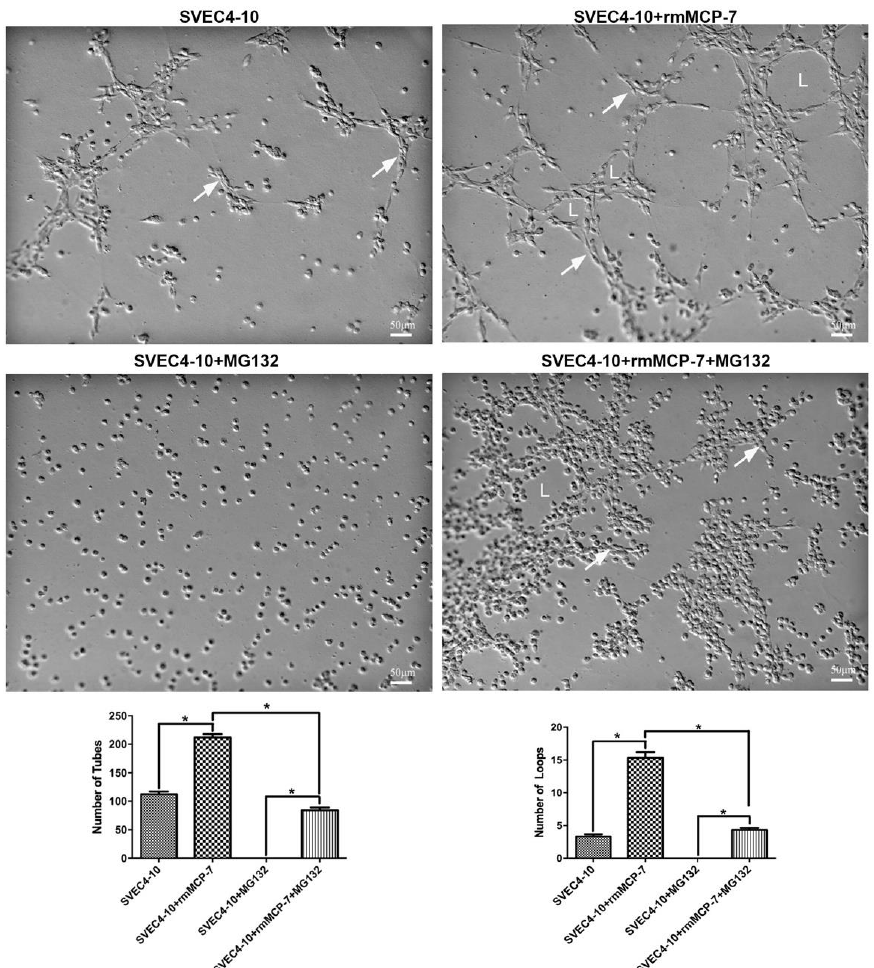
Figure 6. rmMCP-7 initiates tube formation even in the presence of the proteasome inhibitor MG132. When SVEC4-10 cells were cultured in the presence of MG132, in vitro angiogenesis was completely inhibited. However, when the cells were cultured with rmMCP-7 in the presence of MG132, in comparison to the cells incubated only with rmMCP-7 tube formation (arrows) is reduced. Furthermore, in the presence of rmMCP-7 and MG132, it is possible to observe a few cells spread on the substrate as well as some loops (L). The cells were incubated for 5 h. Quantification of tube and loop formation using WimTube Wimasis is shown in the graphs. * p <